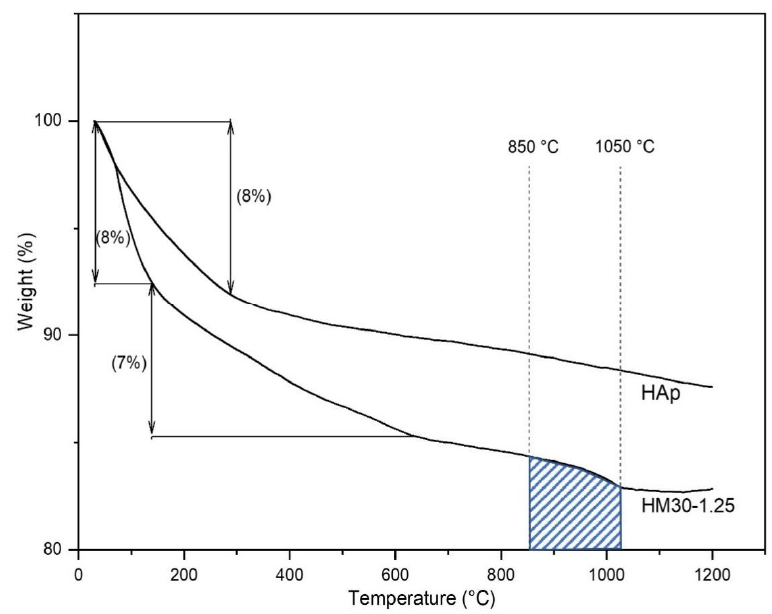
Figure 9. The TGA spectra of HAp and HM30-1.25 powder.